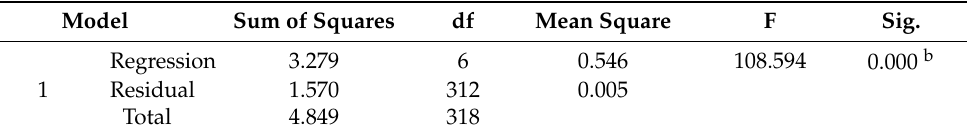
Table 5. Result of Anova